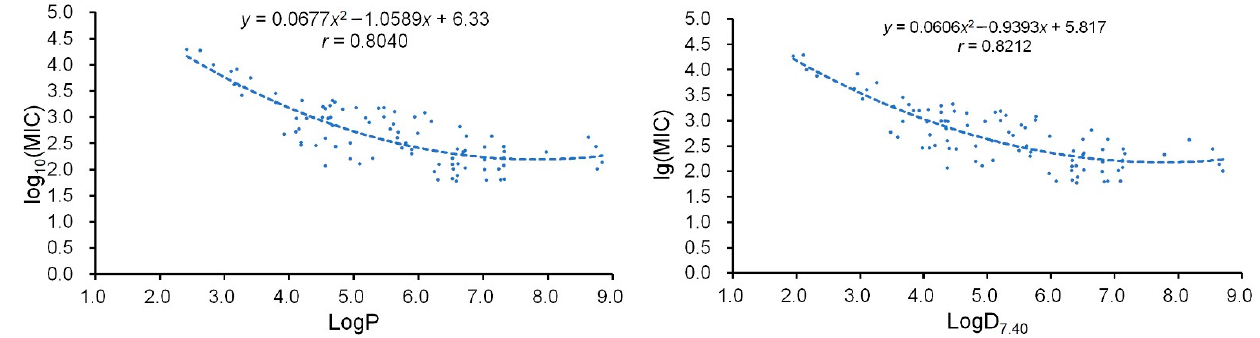
log 10 (MIC) ( y ) to Gram-positive bacteria of ninety-two plant